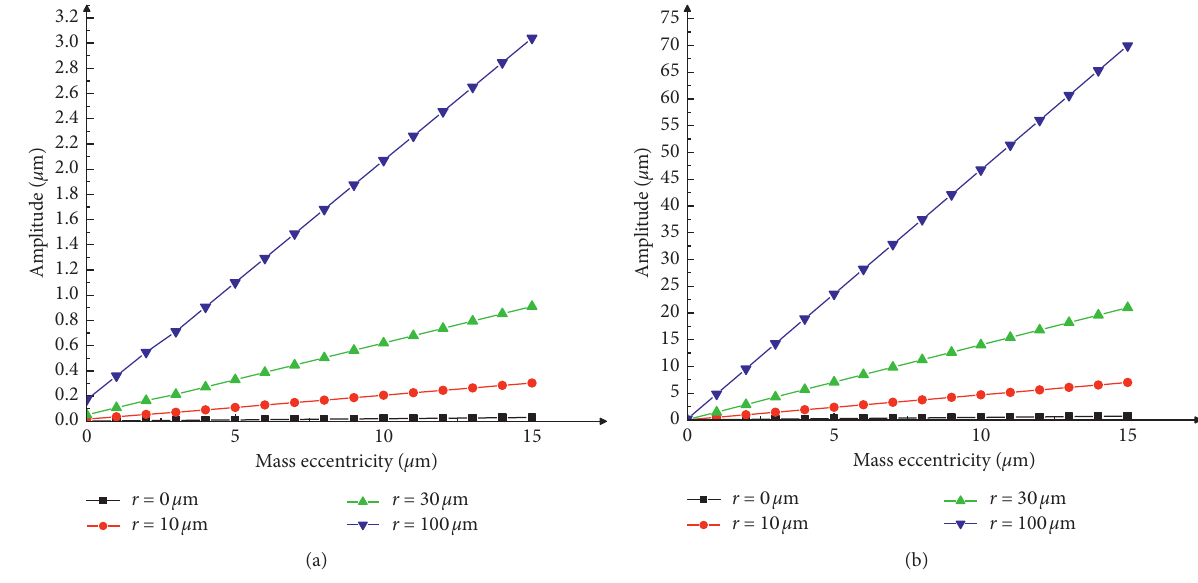
Figure 12: Effect of static eccentricity on vibration under different mass eccentricity at (a) 5000r/min and (b) 30000r/min.